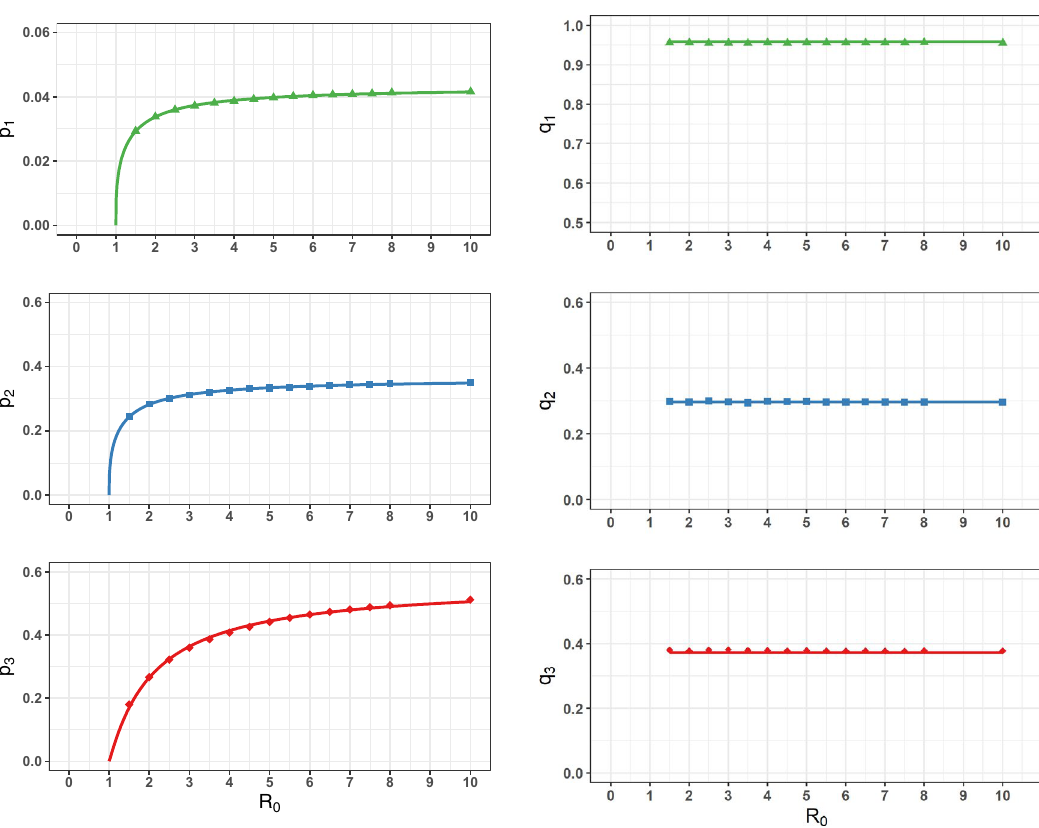
Figure 5. Fractions of antibody positive and infected animals from the diagnostic test results (1, carrying IgM and IgG antibodies; 2, only carrying IgG and 3, carrying high-level of IgG) at 10 years as a function of R 0 . p i stands for the probability of antibody positive results of type “ i ” and q i for the probability of infected individuals among antibody positives of type “ i ”. Solid lines through the data are the best-fit to the data (symbols) with Eq. (9) for p i (left panel) and represent Eq. (10) for q i (right panel). Dashed lines representing the 95% credible intervals are not